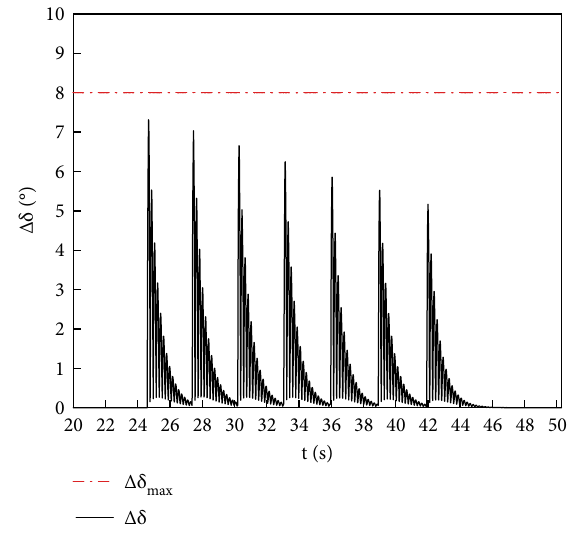
Figure 13: The variation curve of the amplitude of angle-of-attack increment with